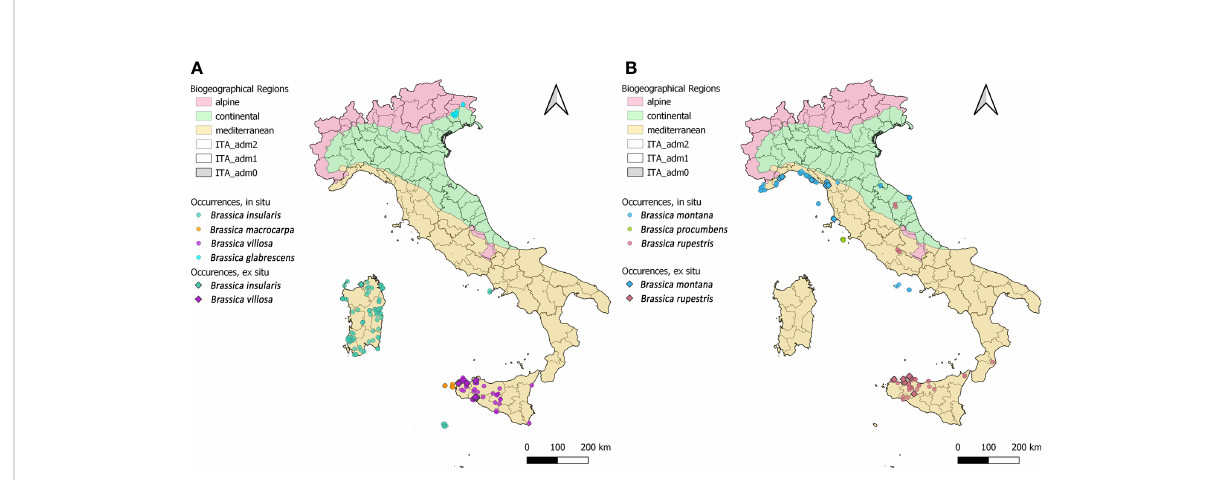
FIGURE 2 Geographical distribution of the 354 in situ (dots) and 31 ex situ (diamonds) Brassica species records; multiple sites with the same geographic coordinates appear as a single locality. To minimise the overlapping of occurrences, the 7 species have been clustered in two groups and represented two separated maps ( A, B , respectively). In each map, the Italian territory is subdivided in its administrative Regions and Provinces, colours of Biogeographic Regions and species symbols are reported in the